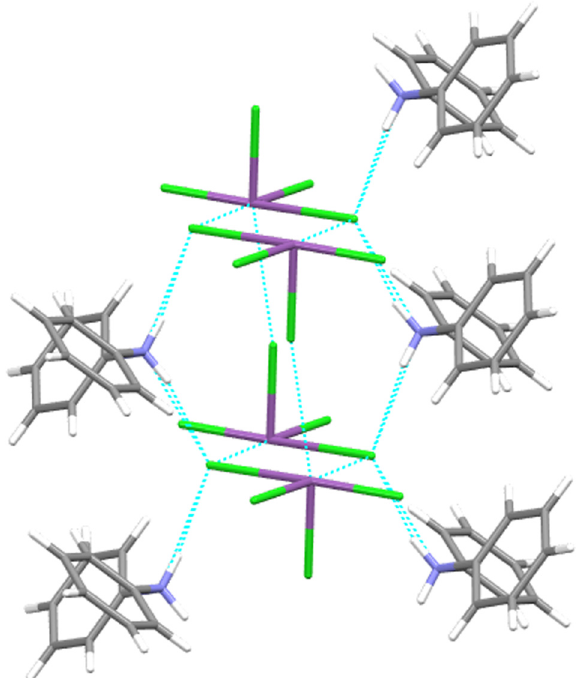
Table  : Data collection and